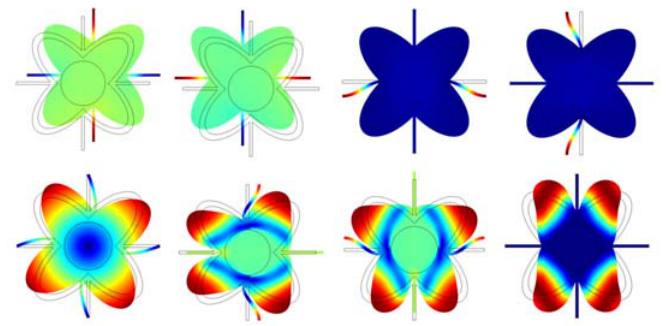
Figure 21. Deformation of microstructures for different eigenfrequencies.